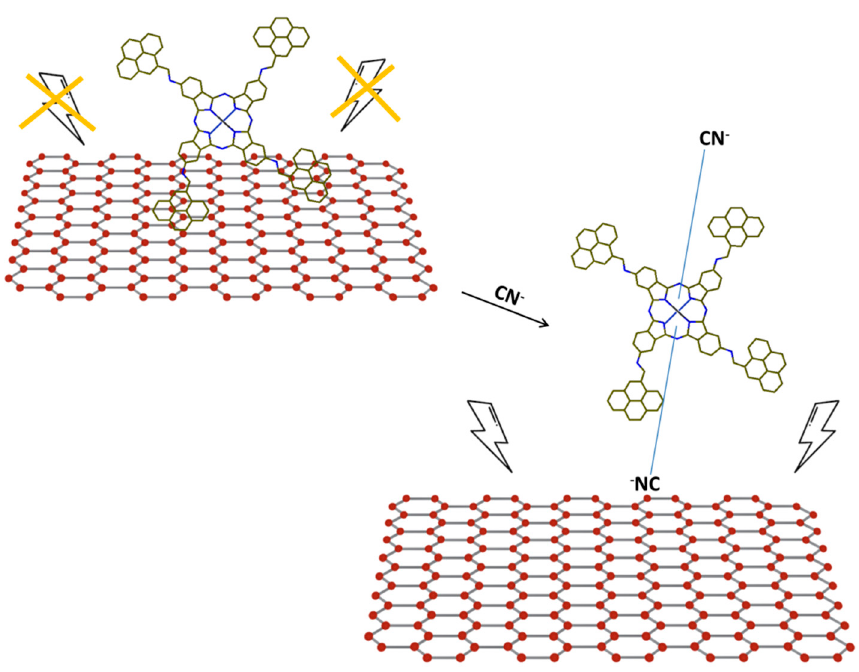
Figure 2. Scheme of the CN − sensing mechanism by supramolecular assembly GQDs-CoPc proposed in the Ref [57].